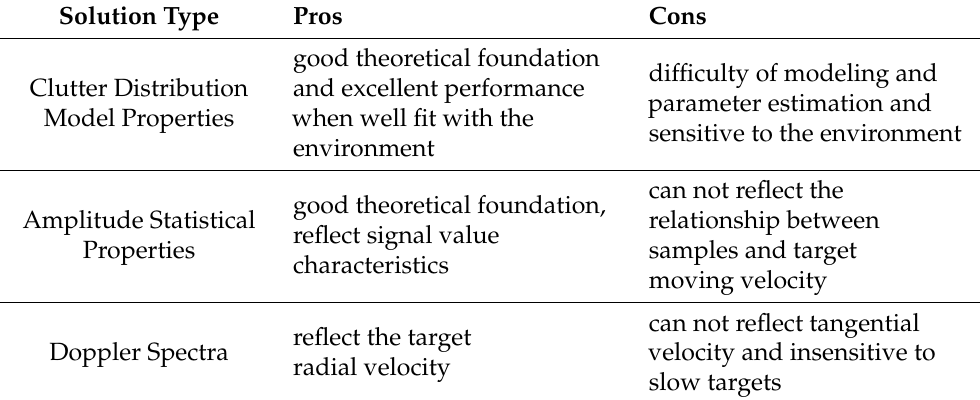
Table 1. Pros and Cons of different feature extraction